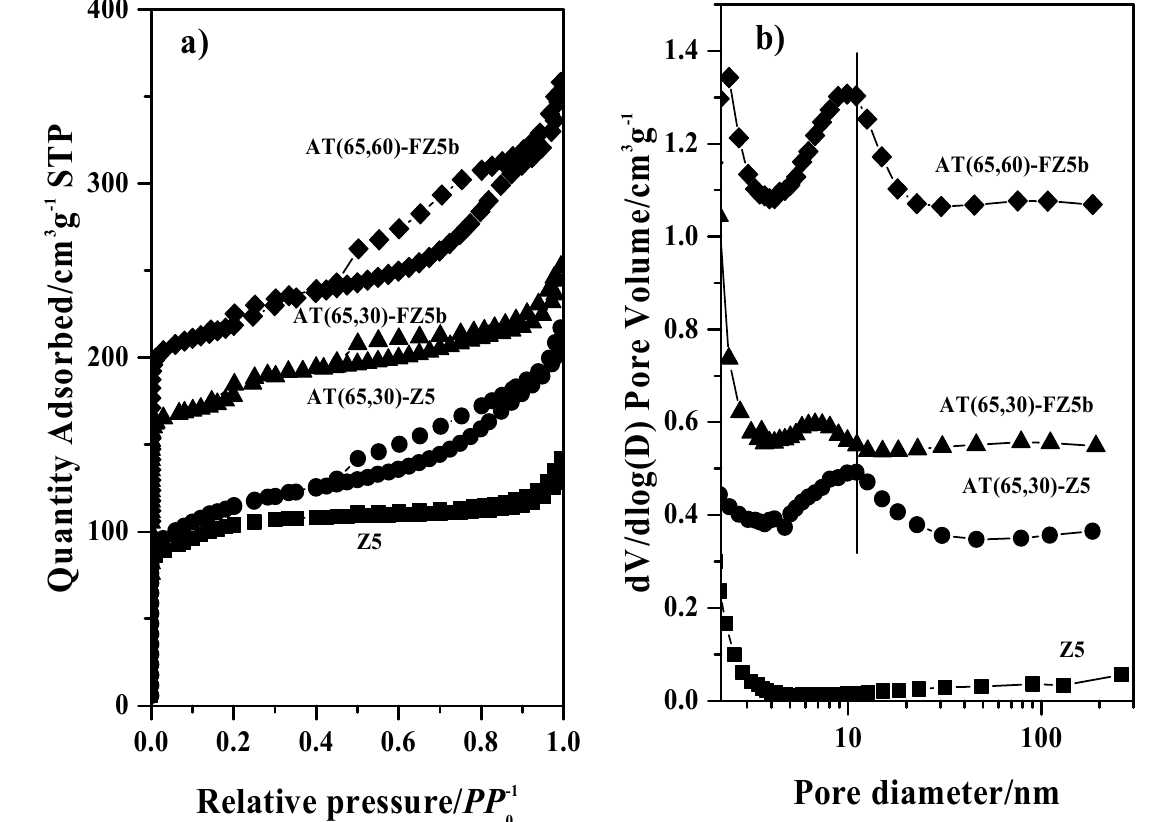
Figure 2. ( a ) N 2 adsorption-desorption isotherms of treated samples at 65 ◦ C. ( b ) BJH pore size distribution derived from the adsorption branches of the isotherms. The isotherms for AT(65,30)-FZ5b and AT(65,60)-FZ5b were offset vertically by 70 and 100 cm 3 g − 1 , respectively. ( b ) Barrett–Joyner– Halenda (BJH) pore size distribution (PSD) data derived from the adsorption branches of the isotherms. The PSD curves of AT(65,30)-Z5,AT(65,30)-FZ5b and AT(65,60)-FZ5b were offset vertically by 0.3, 0.5 and 1.0 cm 3 g − 1 , respectively.